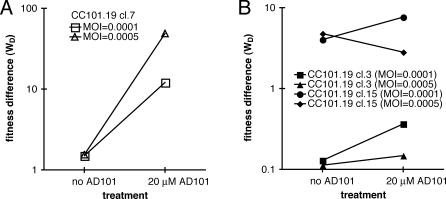
The Effect of AD101 on the Fitness of Clonal, Env-Chimeric AD101-Resistant Viruses(A) Replicative fitness differences in PBMCs after 14 d of culture were determined at MOIs of 0.0001 (open squares) or 0.0005 (open triangles) for the vifX CC101.19 cl.7 virus relative to the vifY NL4–3 reference virus, in the presence of 20 nM AMD3100 and in the presence or absence of 20 μM AD101, as indicated.(B) Replicative fitness differences in PBMCs after 14 d of culture were determined at MOIs of 0.0001 (squares, circles) or 0.0005 (triangles, diamonds) for the vifX CC101.19 cl.3 virus (squares, triangles) or the vifX CC101.19 cl.15 virus (circles, diamonds), relative to the vifY CC101.19 cl.7 reference virus, and in the presence or absence of 20 μM AD101, as indicated. In both panels, the plotted values are derived from the mean virus proportions from three independent experiments.